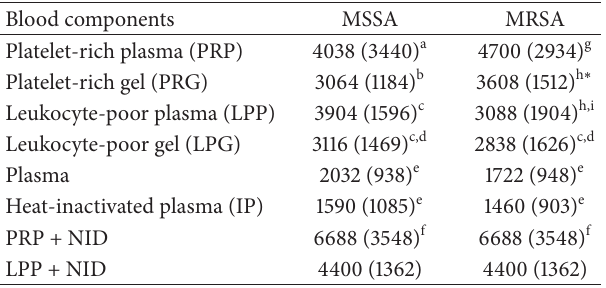
Table 4: TGF- 𝛽 (pg/mL) concentration in every blood component 1 cultured with either MSSA or MRSA at 6 hours.